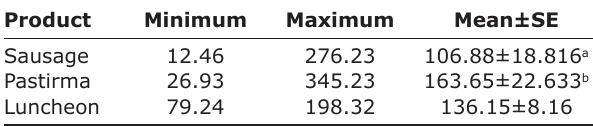
Table-1: Statistical analytical results of residual nitrite levels (ppm) in examined meat products.